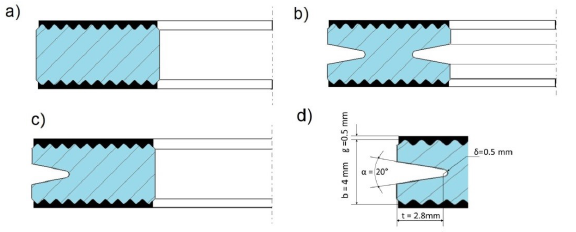
Figure 3: The solutions of the gaskets a) standard gasket, b) gasket with symmetrically grooved core, c) gasket with core grooved